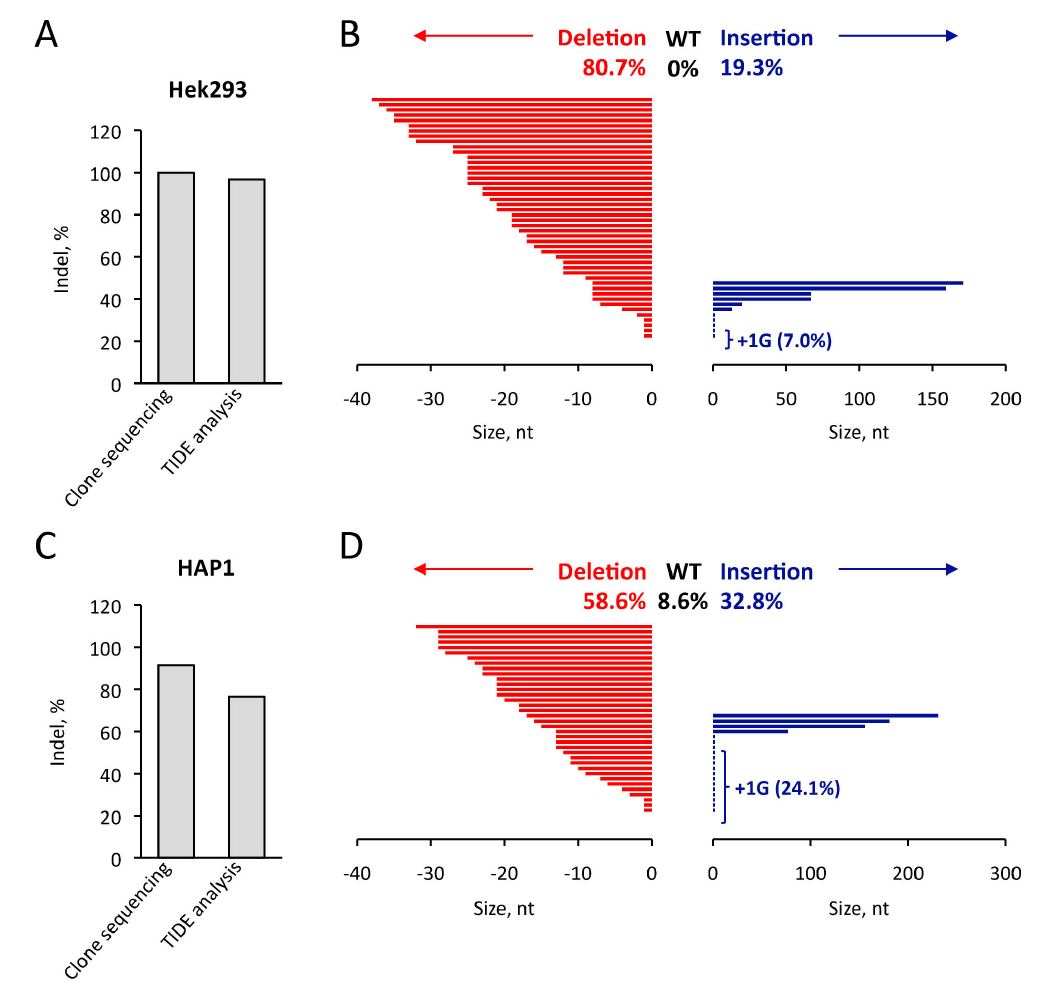
Figure 5. Analysis of the Cas9 induced mutations found in Hek293 and HAP1 cell lines. Genomic DNAs extracted from Hek293 and HAP1 cells treated with 20 pmol of Cas9 tRNA VLPs were used as a template for PCR amplification and cloning into a PCRII cloning vector. The sequences of the plasmid DNAs obtained from 57 and 58 colonies (Hek293 et HAP1, respectively) were used to calculate total genome editing e ffi ciency (deletion plus insertion) at the TRNAU1 locus. This e ffi ciency was compared to the one obtained by TIDE in Figure 4, for Hek293 ( A ) and HAP1 ( C ) cells. After alignment with the WT sequence, the size of the deleted (red) or inserted (blue) nucleotides are indicated in a histogram for Hek293 ( B ) and HAP1 ( D )